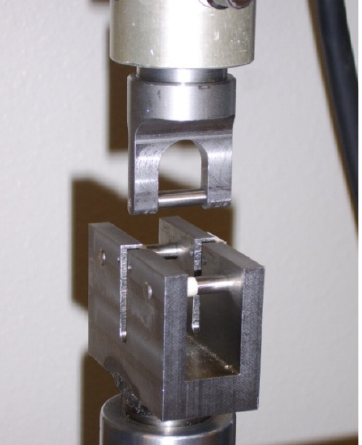
Figure 5. 3-point flexural beam test fixture in loadframe. Test span is 45.4